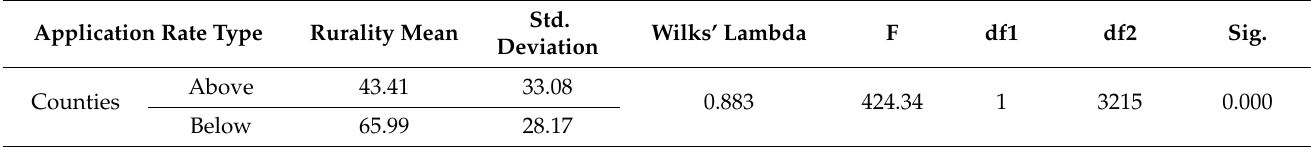
Table 3. Tests of equality of group means.